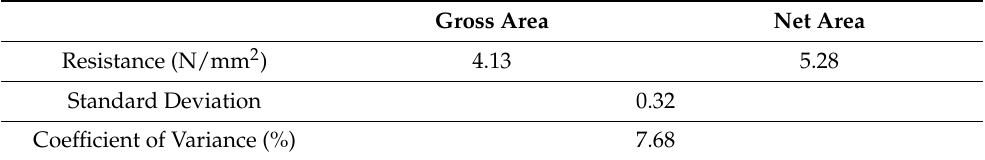
Table 3. Mechanical strength to compression: average of the